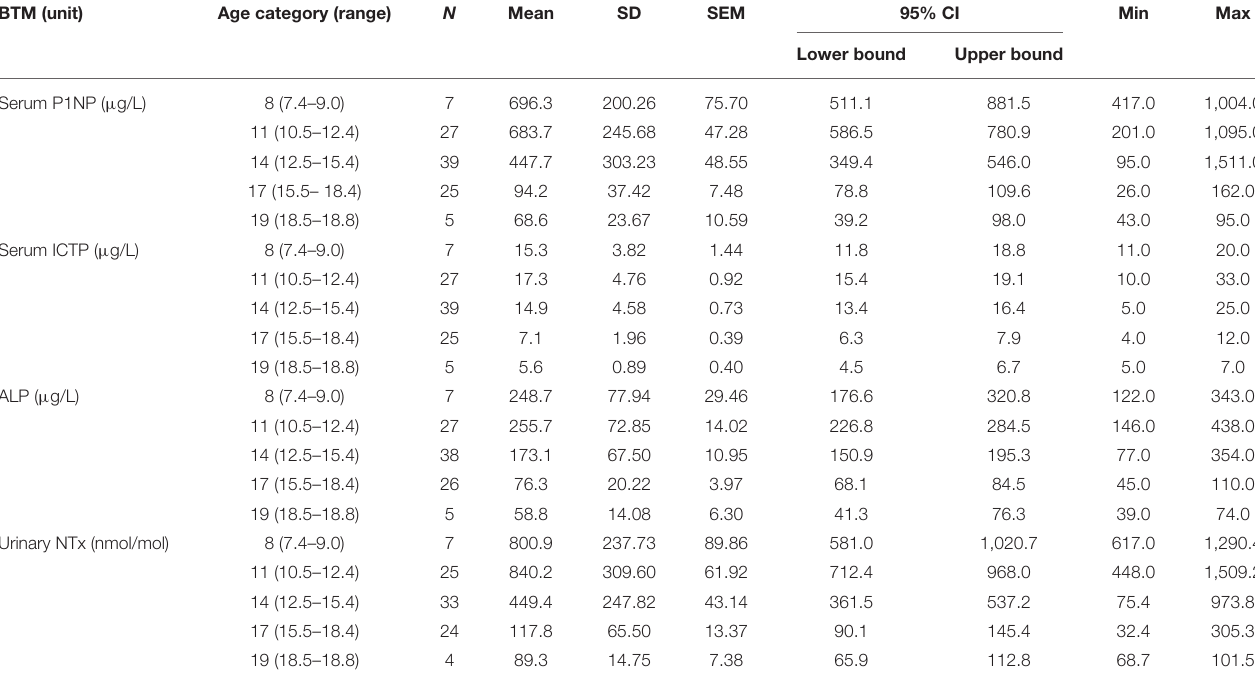
TABLE 1A | Serum P1NP, ICTP, ALP, and urinary NTx concentrations per age category for girls. BTM (unit)